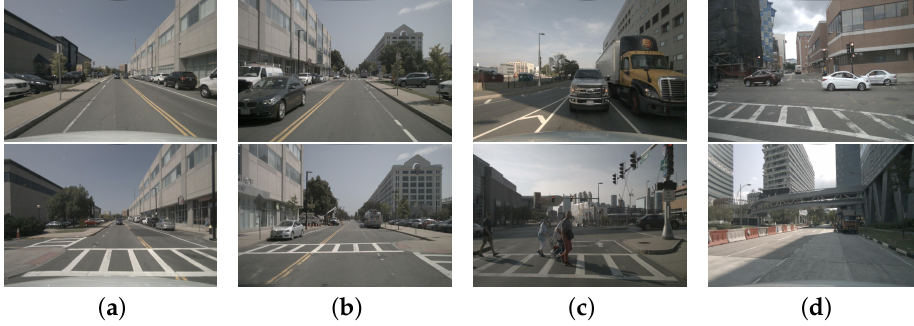
Figure 15. Traffic scene images of nuscenes data set, where ( a – d ) are images of intersections, office buildings and residences on different streets.